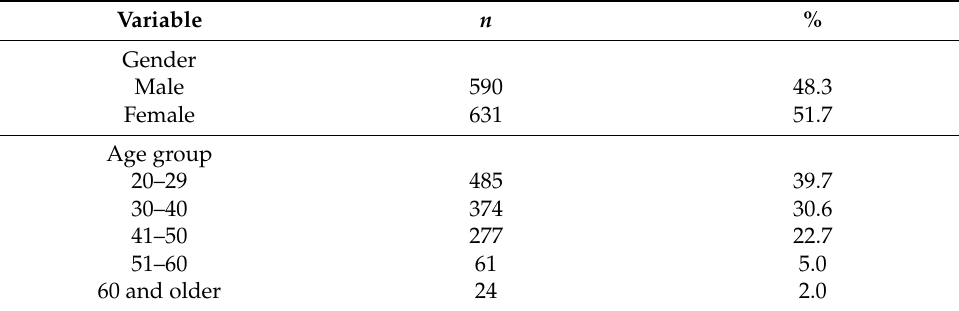
Table 2. Demographic characteristic of sample ( n =